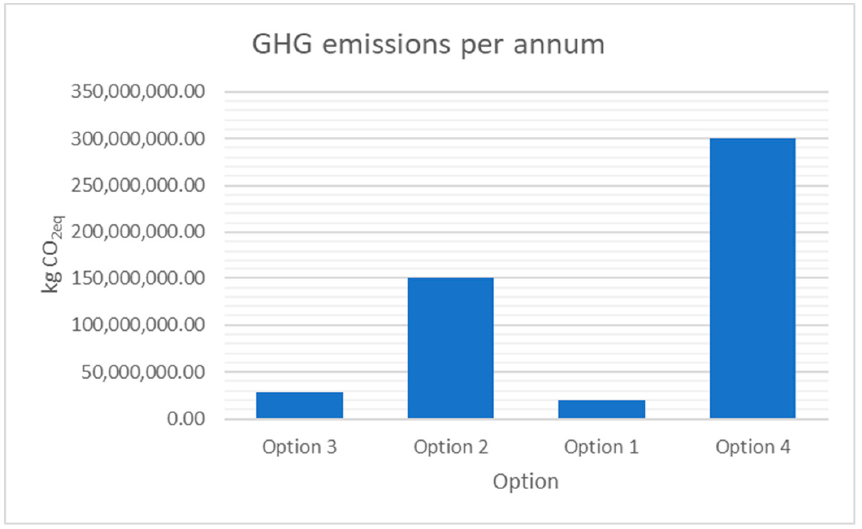
Figure 6. GHG emissions for each facility per annum.